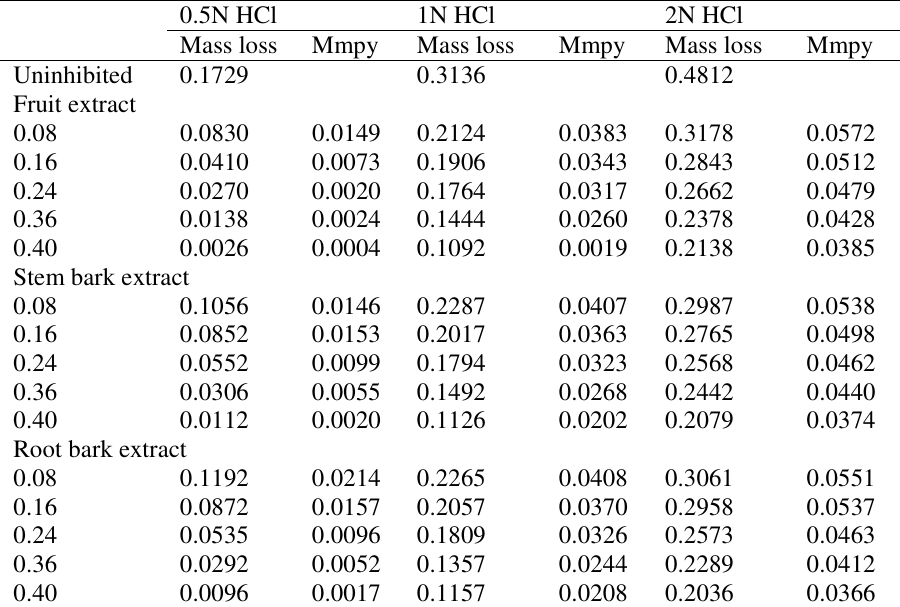
Table 1 . Mass loss and corrosion rate (mmpy) for aluminium in hydrochloric acid solution with given inhibitor addition at room temperature for Capparis decidua